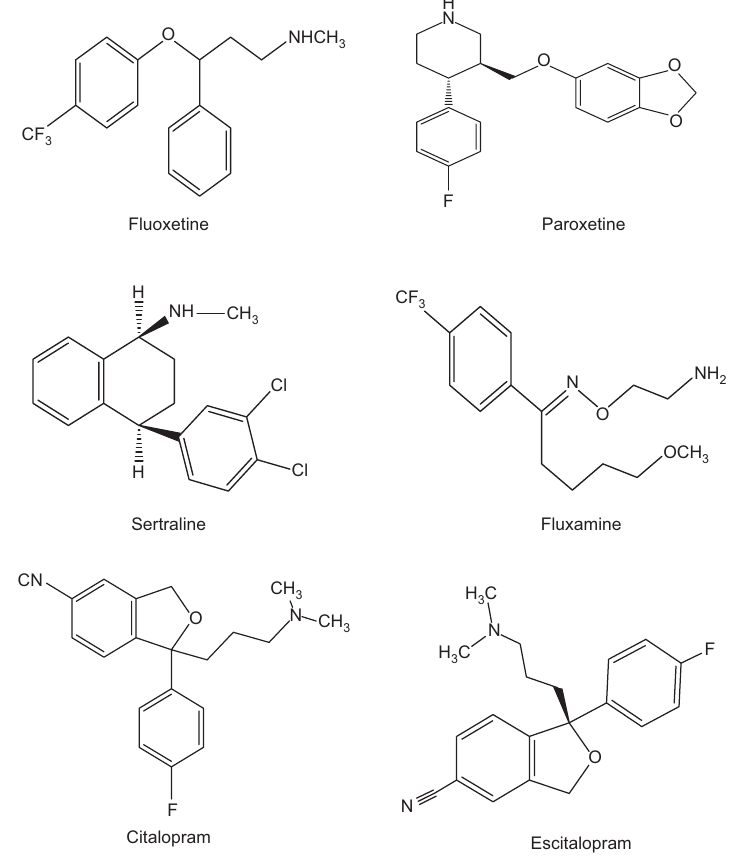
Figure 1 Chemical structures of